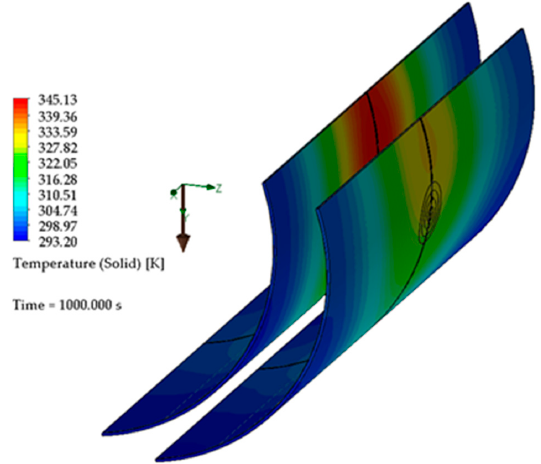
Figure 23. Temperature at 1000 s.